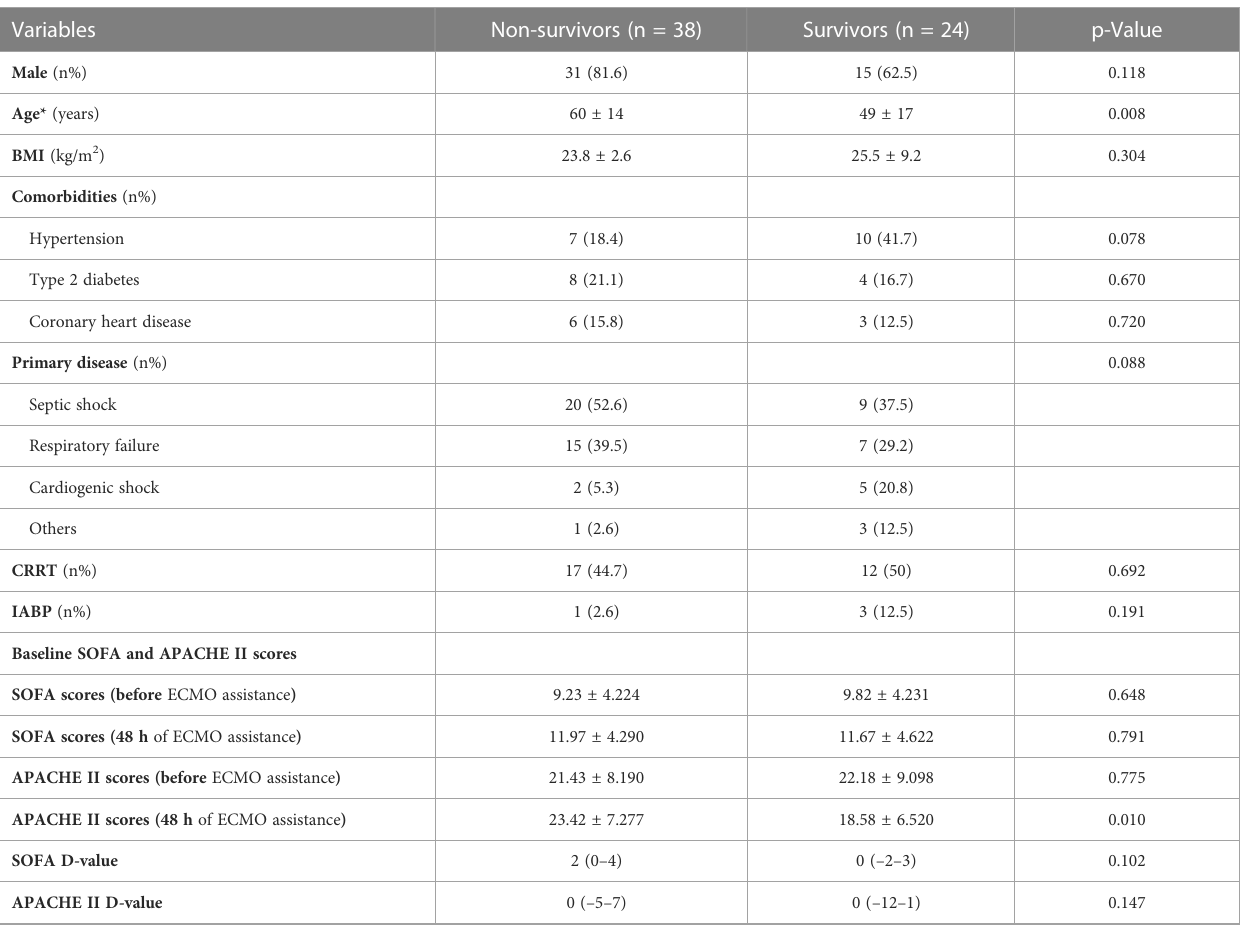
TABLE 1 Baseline characteristics of ECMO